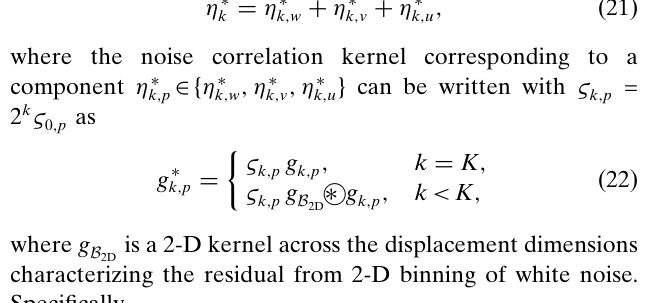
Figure 1 Top: example noise (cid:2) 0, p , the corresponding kernels g 0, p and the root PSD jF ½ g (cid:10)j for each noise component in (17) with & 0 ; p 8, as well as example noise, kernel, and root PSD corresponding to the compound noise (cid:2) k . Bottom: example noise, the corresponding kernels, and root PSD of the corresponding binning residuals (cid:2) (cid:7) visualizations, the angular dimension of the data is the vertical dimension in the figure. The DC corner of the Fourier spectra is marked by a circle. Note that all root PSDs are nonzero only on the angular DC plane, and the kernels and the noise consist of repeated planes across the